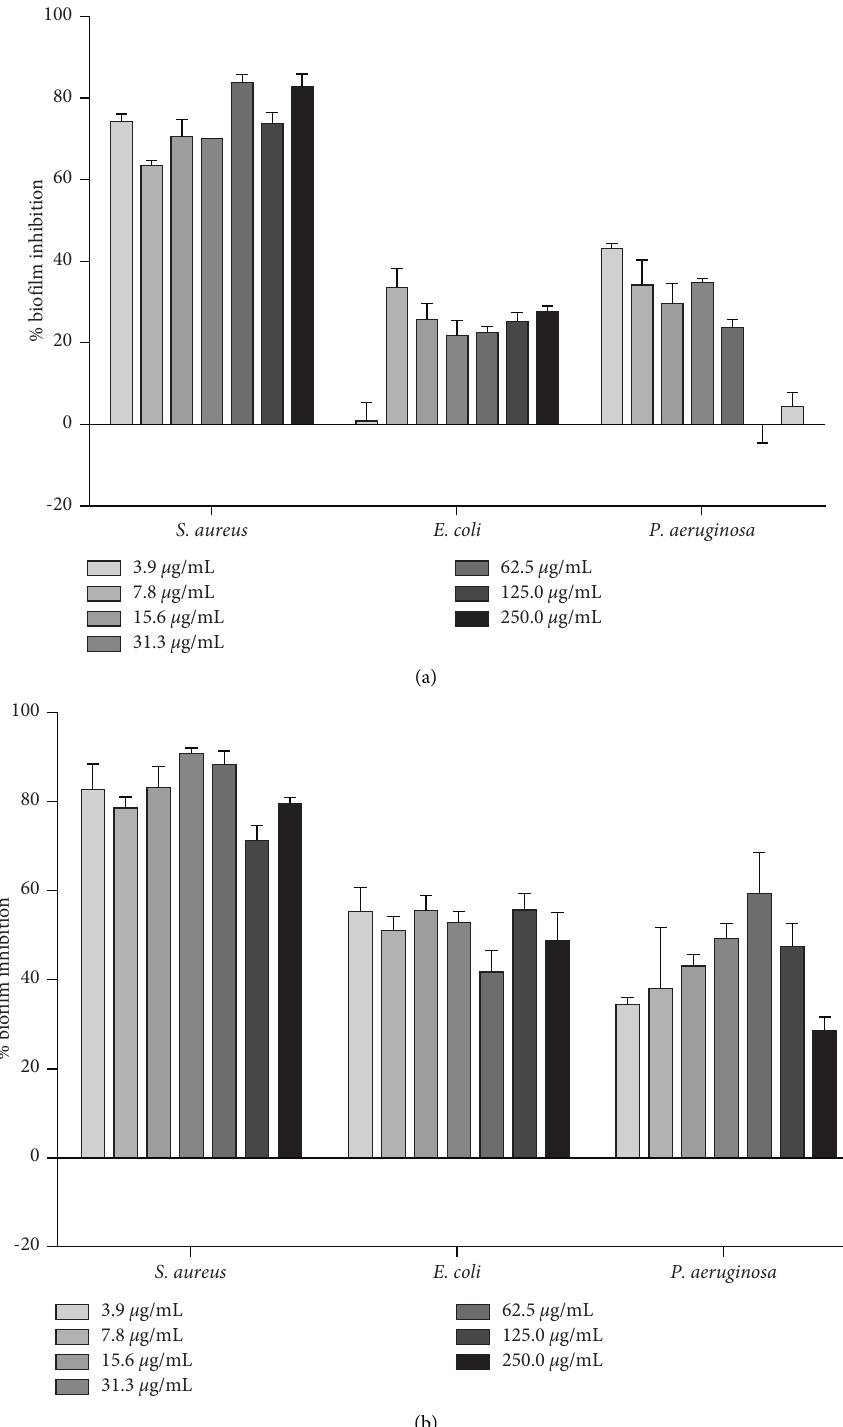
Figure 1: Antibiofilm formation activity of the crude extract, ACF (a), and the MeOH fraction, AMF (b), in S. aureus , E. coli , and P. aeruginosa